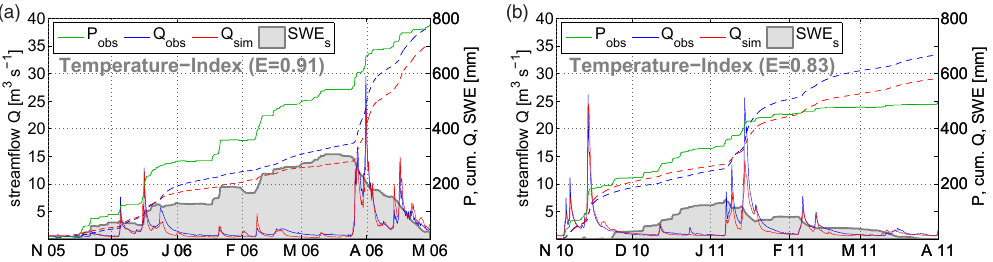
Figure 6. Streamflow simulations at the catchment scale using observed meteorological time series: (a) winter season 2005–2006, (b) winter season 2010–2011. For every simulation run, observed precipitation depth ( P obs ), observed streamflow ( Q obs , blue line), observed runoff depth (blue dashed line), simulated streamflow ( Q sim , red line), simulated runoff depth (red dashed line), and simulated snow water equivalent (SWE s ) are plotted. Model efficiencies E are also given for each run.